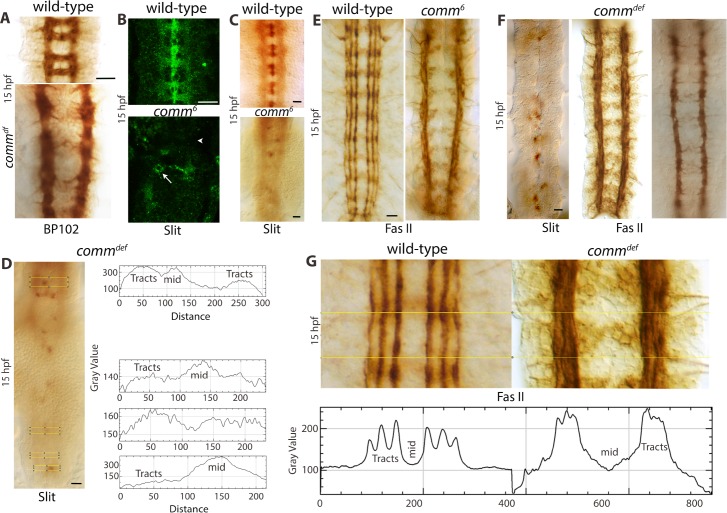
comm mutant embryos show a loss of Slit in tracts, the funneling phenotype and defasciculation of tracts.(A): BP102-stained wild-type and commdeficiency (df) mutant embryos. Only a few commissural axons cross the midline in a random fashion in comm mutants. Note the funneling phenotype of longitudinal connectives towards the posterior region in comm embryos. Scale bar: 8 μm. (B): Slit-stained wild-type and comm mutant embryos, analyzed with confocal microscopy. Note the characteristic midline and commissural staining of Slit in wild-type, and the absence of such a staining in comm. In comm, Slit-positive midline glial cells are often mislocated (arrow) and tract staining is mostly absent (arrowhead) or seen in intermittent regions. Scale bar: 8 μ. (C): Slit-stained wild-type and comm mutant embryos. In comm, the abundance of Slit is progressively affected towards the posterior region of the nerve cord. The funneling phenotype of the longitudinal connectives is also seen. About half of the comm mutant embryos show this pattern. Scale bar: 8 μm. (D): ImageJ analysis of Slit in a comm mutant embryo. The yellow box shows the area of analysis of the Slit profile, presented next to the image. Note the gradual loss of Slit expression from the anterior to the posterior region, as well as the narrowing of the longitudinal connectives. The word mid in ImageJ tracings represents the midline. Scale bar: 8 μm. (E): Fas II-stained wild-type and comm mutant embryos. Note the funneling phenotype in comm mutant embryos. The tracts are located farther apart and this is primarily due to the midline defect in comm embryos (see Fig 6 and Table 1). Scale bar: 8 μm. (F): Slit, Fas II and BP102-stained comm mutant embryos, respectively. Note the presence of Slit throughout the longitudinal connectives, although at a lower abundance and the connectives do not show a noticeable funneling phenotype. The Fas II tracts or the BP102 stained connectives also do not show any significant funneling phenotype in such embryos. About 50% of the comm mutant embryos show this pattern. Scale bar: 8 μm. (G): Fas II-stained wild-type and comm mutant embryos with ImageJ analysis. The yellow box shows the area of ImageJ analysis with profile shown below the image. M, medial tract; I, intermediate tract; L, lateral tract. Note the fraying of longitudinal tracts in comm, also illustrated by the ImageJ analysis, which signifies defasciculation of axon tracts. Scale bar: 8 μm.